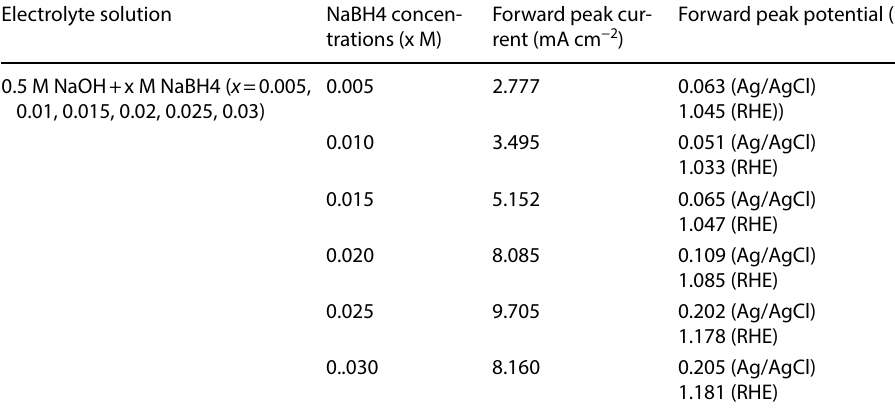
Table 4 Forward peak current densities and corresponding peak potentials from Fig.